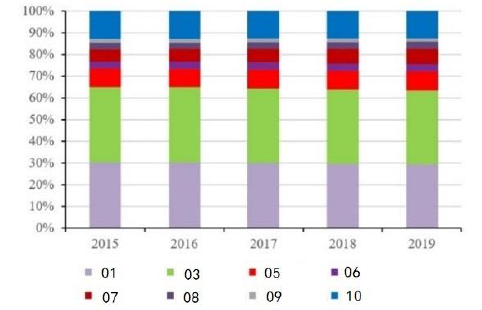
Figure 3 . Quantitative composition of the coastal landscape types from 2015 to 2019. The land type codes are detailed in Figure 1.